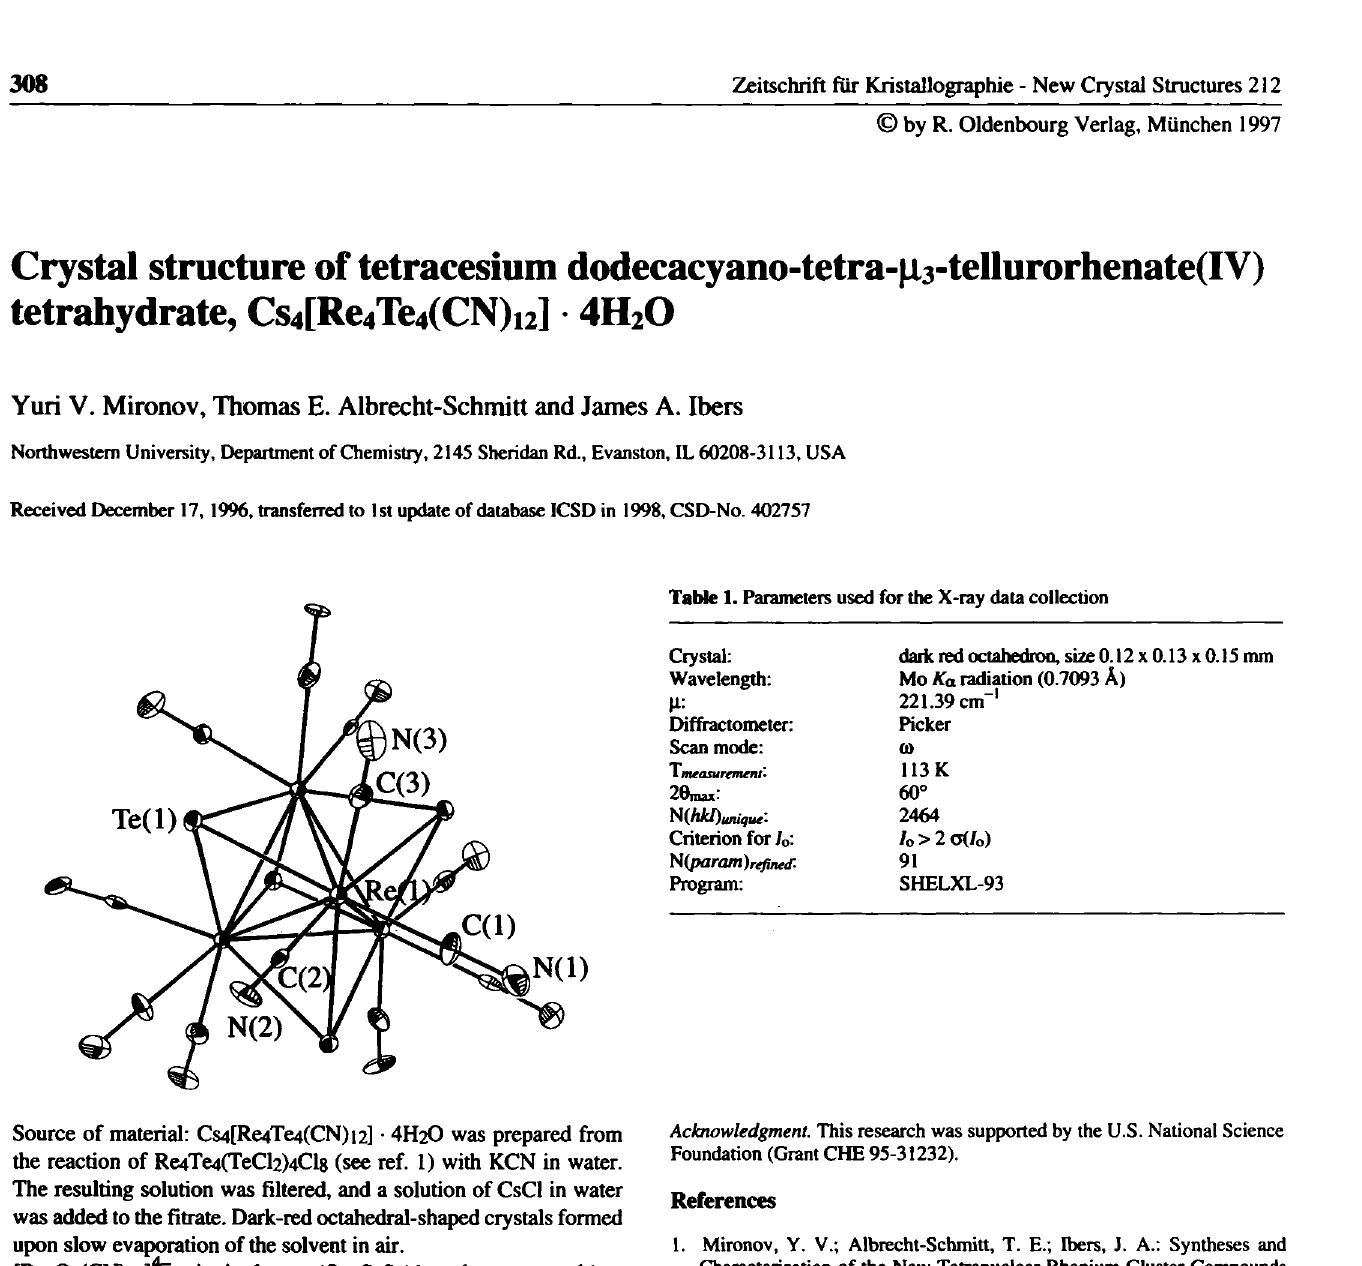
Table 2. Final atomic coordinates and displacement parameters (in Â 2